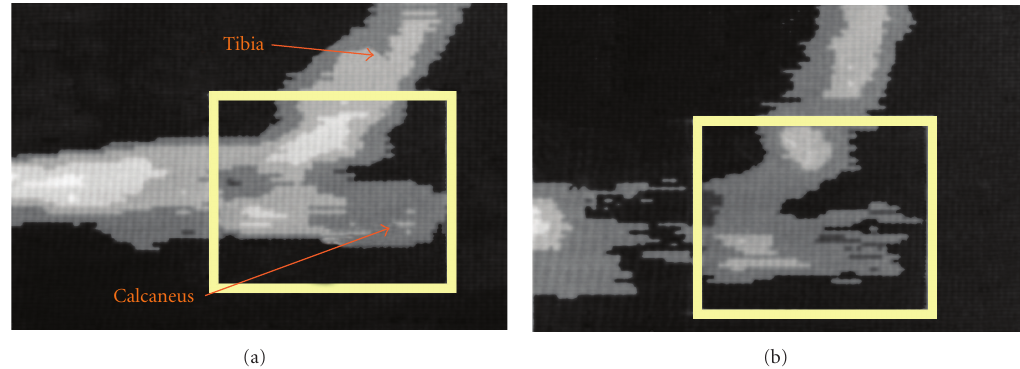
Figure 4: Bone mineral density (BMD) of the tibiotarsal region (hock (or “ankle”)) by dual X-ray absorptiometry (DXA) is a rapid means of evaluating bone integrity in arthritic rodent hind paws. Relative to a nonarthritic control (a), BMD is greatly reduced in multiple bones (bordered by the yellow rectangle) of a young adult, male Lewis rat with the mycobacterial variant of adjuvant-induced arthritis (AIA-Myc). These panels are reproduced from [155] with the permission of the American College of Rheumatology.